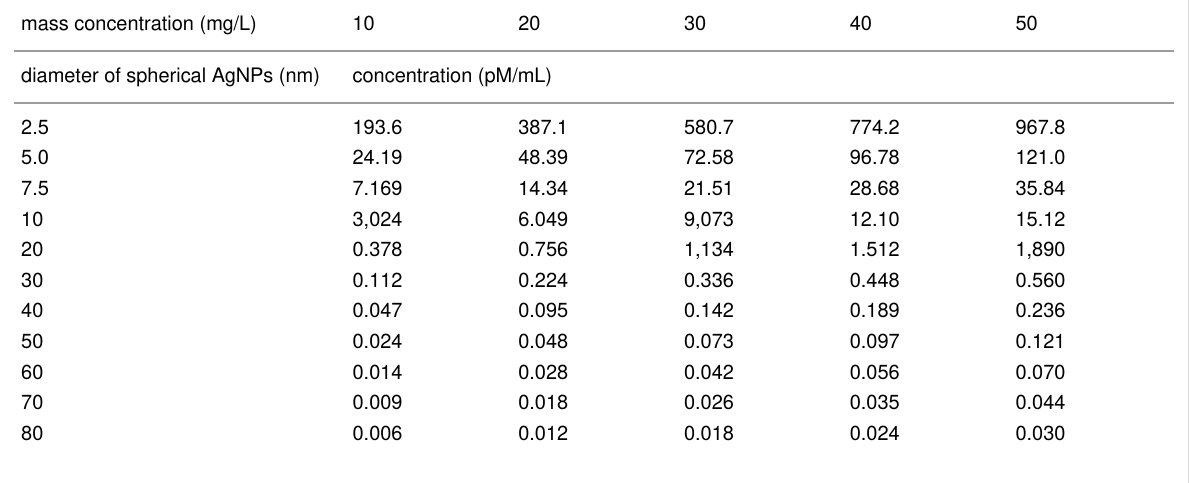
Table 4: Conversion table from mass concentration (mg/L) to particle concentration in pM/mL depending on the size of the spherical AgNPs. mass concentration